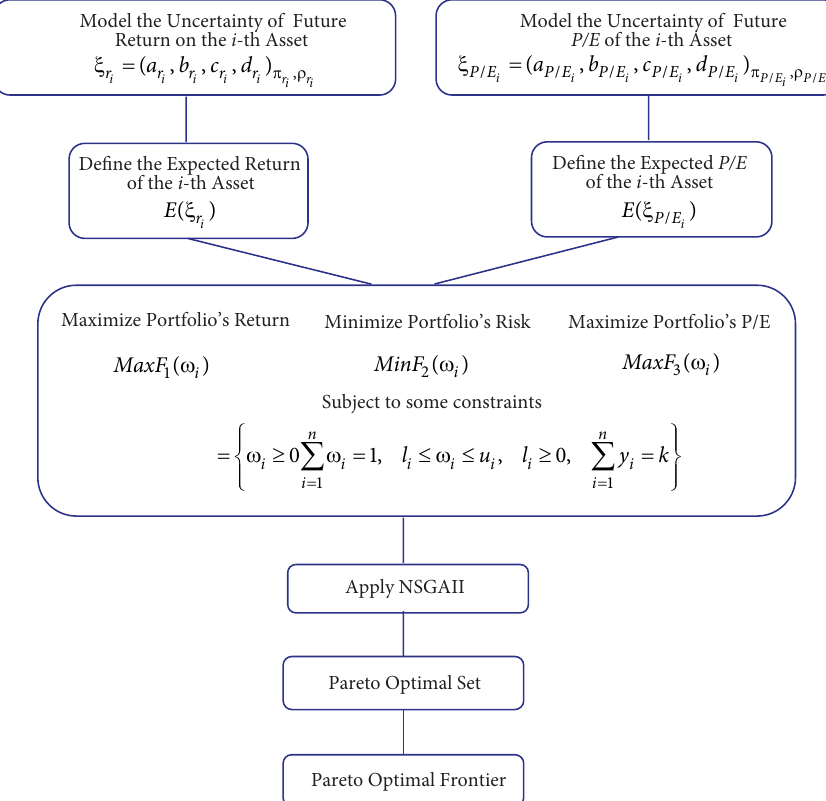
Figure 2. Overall structure of the multiobjective credibilistic mean-semivariance-PER portfolio selection